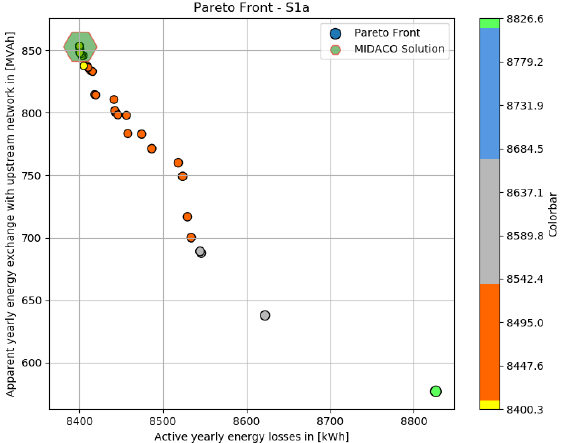
Figure 16. The Pareto front of the solved multi-objective optimization problem for Opt 1 (Figure 1).